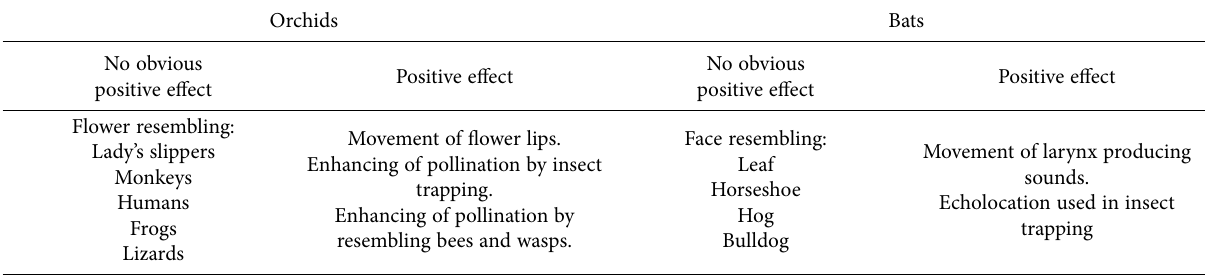
Table 6. Structures and functions with no obvious positive effect for the organism and those with a positive effect.